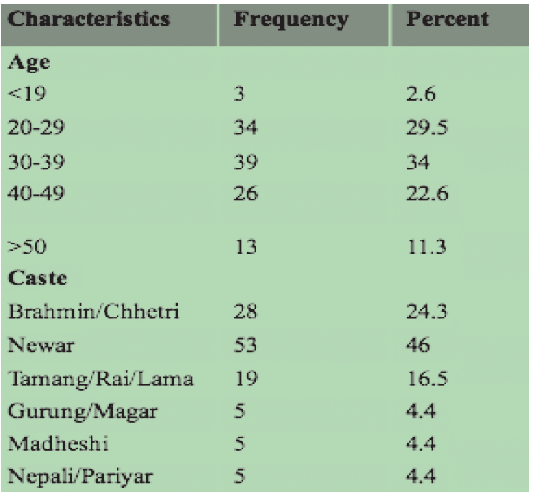
Table 1: Patient demograph ics